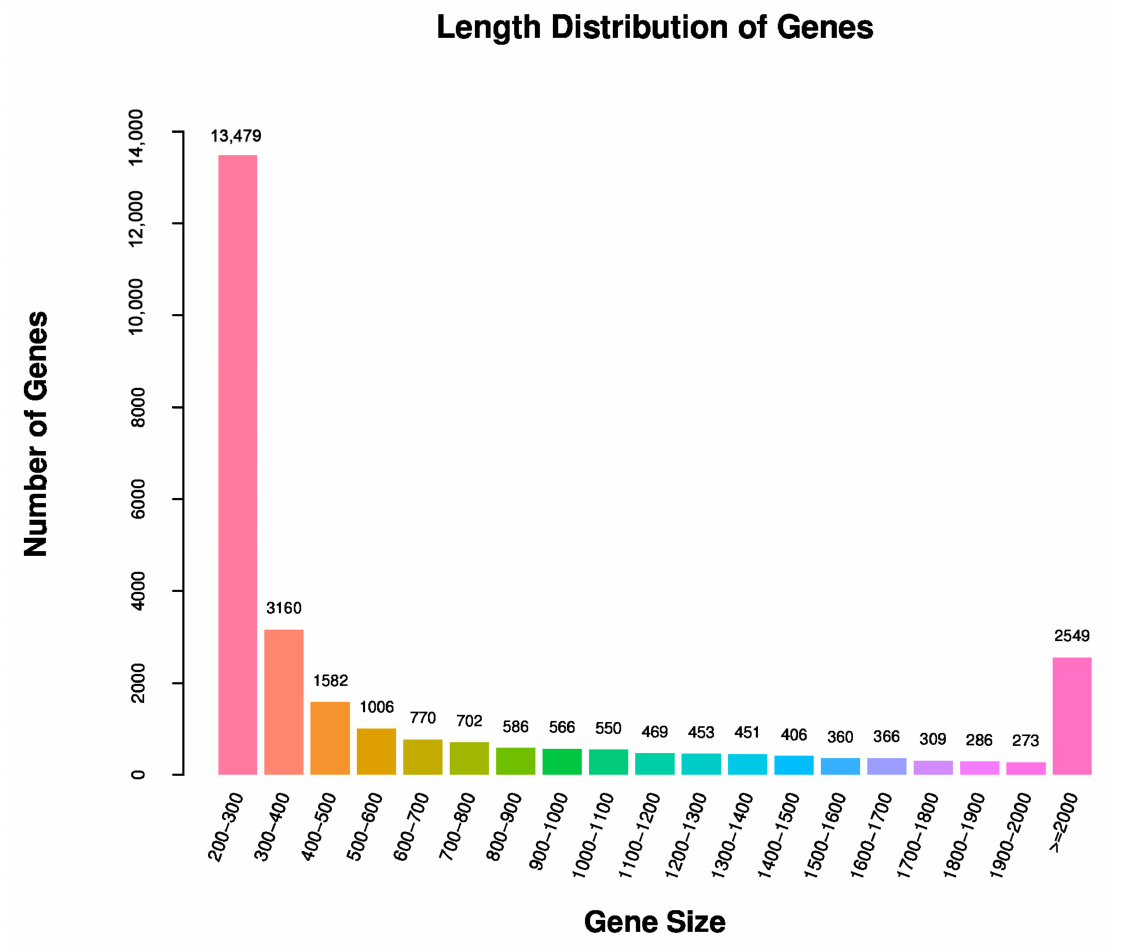
Figure 1. Distribution of unigene size in the M. sanborni antennal transcriptome